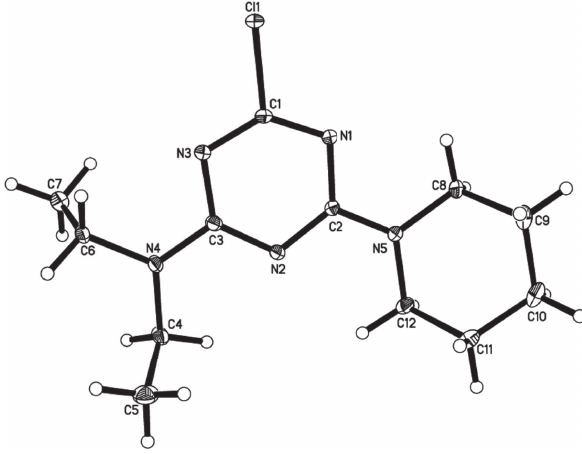
Table 1: Data collection and handling.